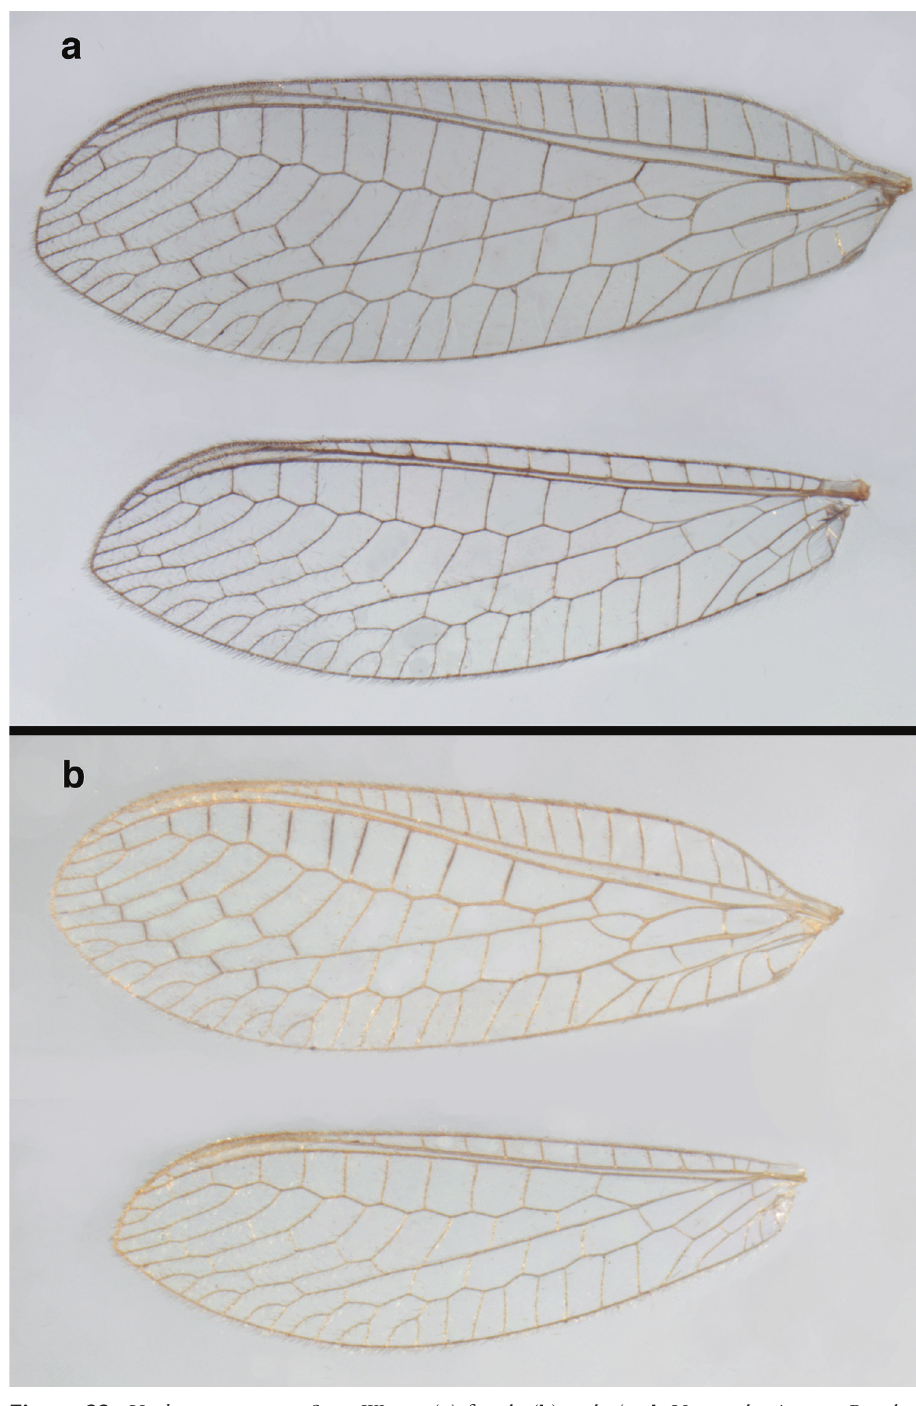
Figure 22. Ungla curimaguensis Sosa: Wings, ( a ) female ( b ) male ( a, b Venezuela, Aragua, Rancho Grande,